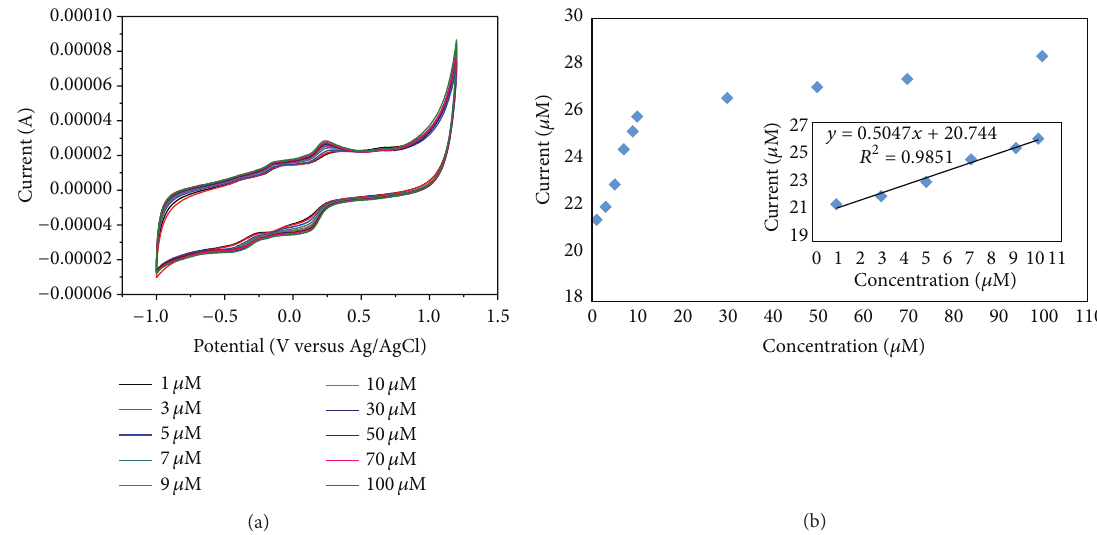
Figure 10: Cyclic voltammograms (CV) of the acetylcholine with the AChE-ChOx-modified biosensor based on a GCE in 0.1 M PBS (pH = 7.0) with 1 𝜇 M ∼ 100 𝜇 M acetylcholine with a scan rate 50m/s and calibration